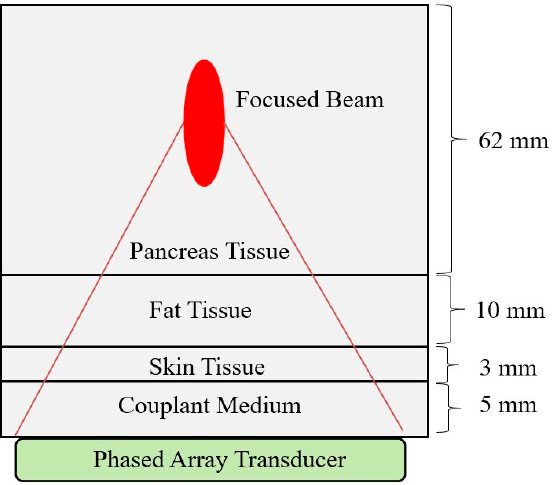
Figure 1. Focused ultrasound simulation through tissue layers consisting of couplant gel, skin, fat, and pancreas tissue. The simulation volume is 80 × 60 × 12 mm 3 .